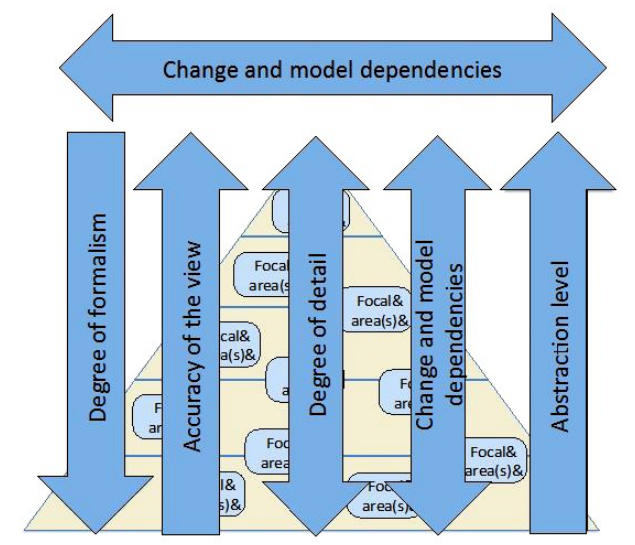
Figure 2. Dimensions of EM and business and IT alignment